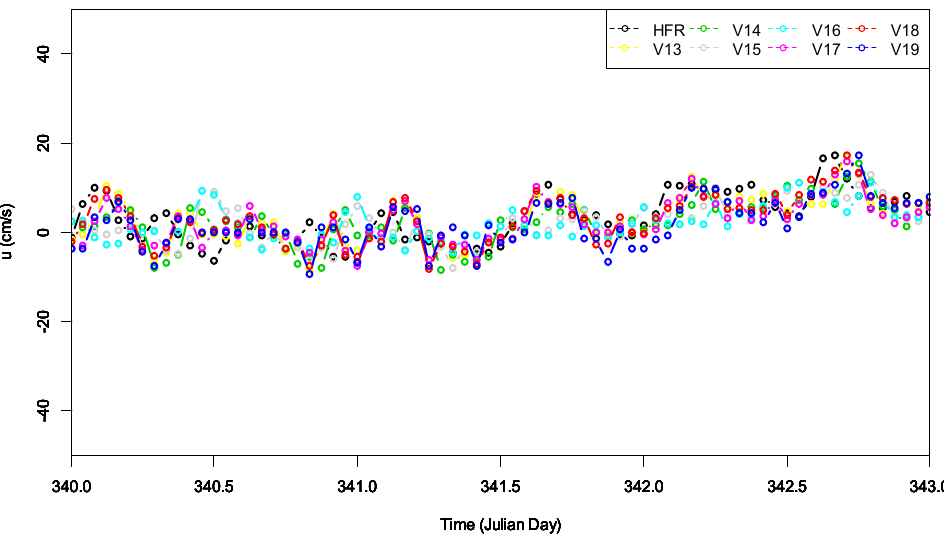
Figure 11. Forecasts of v velocity component at A3.